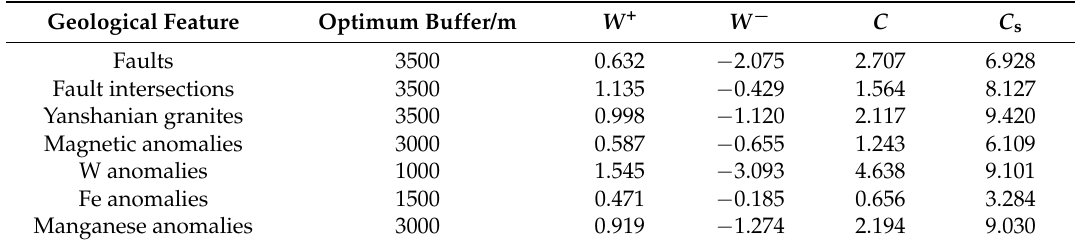
Table 2. Resultant indices calculated from buffer analysis and Student’s t